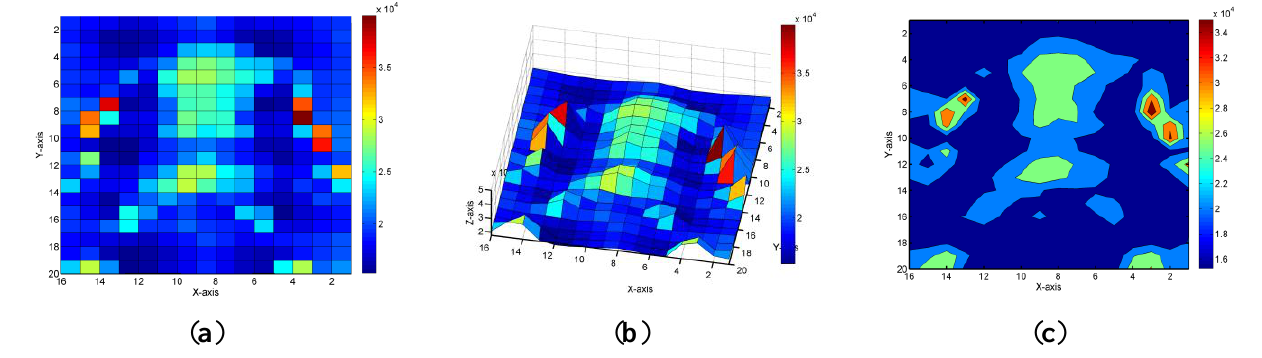
Figure 11. A sensory map of a participant lying on the FPCSM in the right lateral